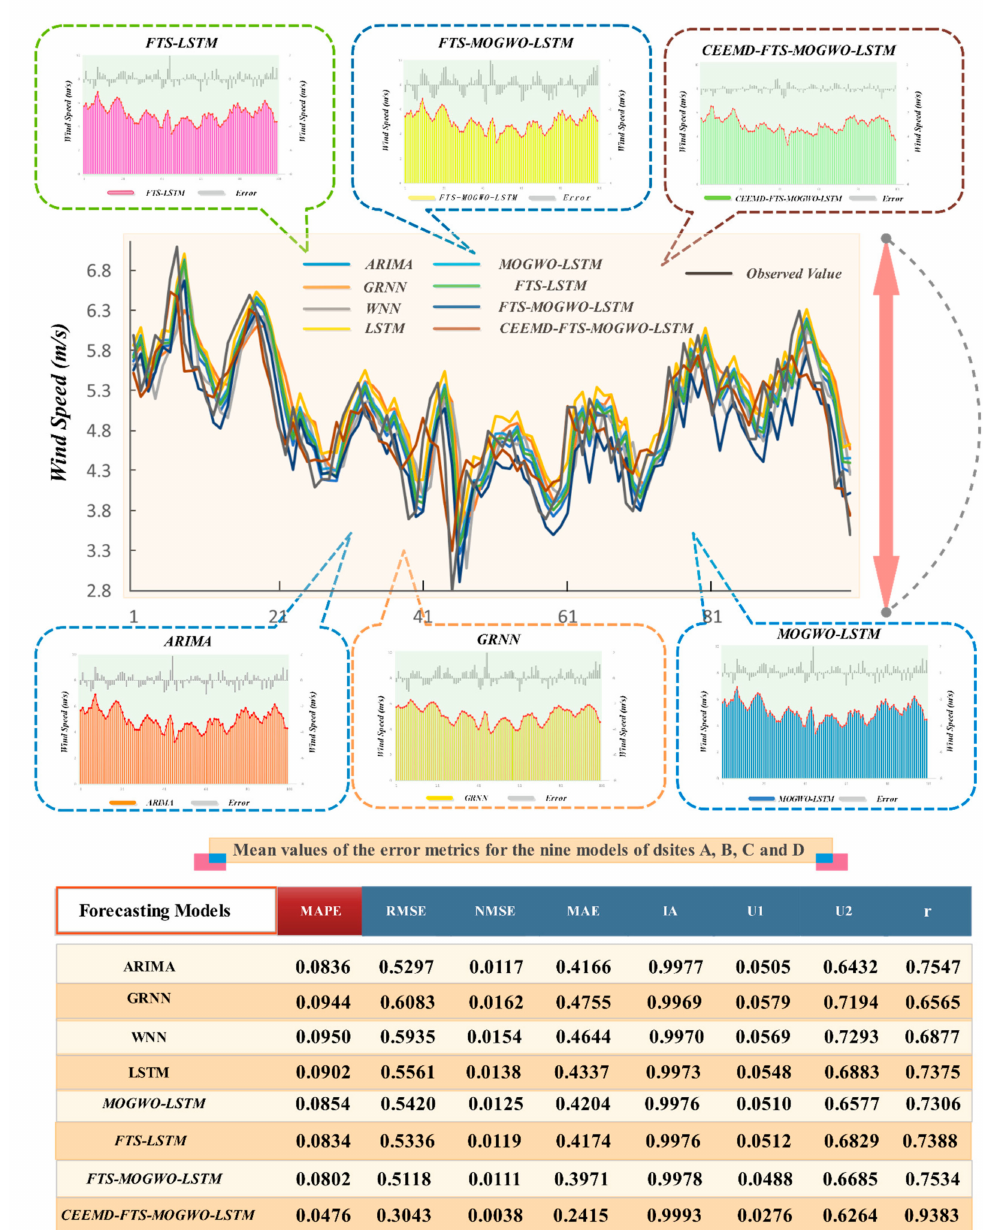
Figure 9. Forecasting results of the developed forecasting system and the other compared models (Experiment